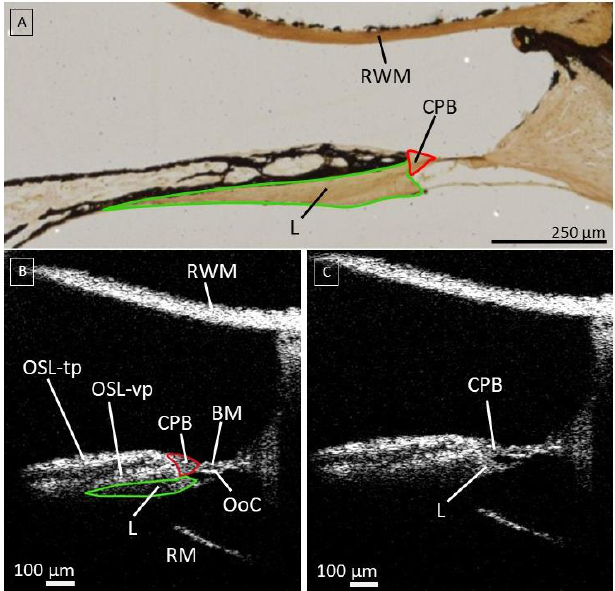
Figure 3. ( A ): Histological slice using von Kossa/von Gieson staining to illustrate the location of the CPB and L. ( B ); The cochlear partition bridge (CPB), aligned in red, is visible as a less reflective structure compared to the osseous spiral lamina illustrated in image ( C ). It is narrow at the base of the cochlea, indicated in the red circle in ( B ). The spiral limbus is aligned in green. ( C ) Same picture without labels and markings. A-scan rate of 10 kHz; Abbreviations: Round window membrane (RWM), Osseous spiral lamina — tympanic plate (OSL-tp), vestibular plate (OSL-vp), cochlear partition bridge (CPB), Basilar Membrane (BM), Organ of Corti (OoC), Spiral Limbus (L) and Reissner’s Membrane (RM).